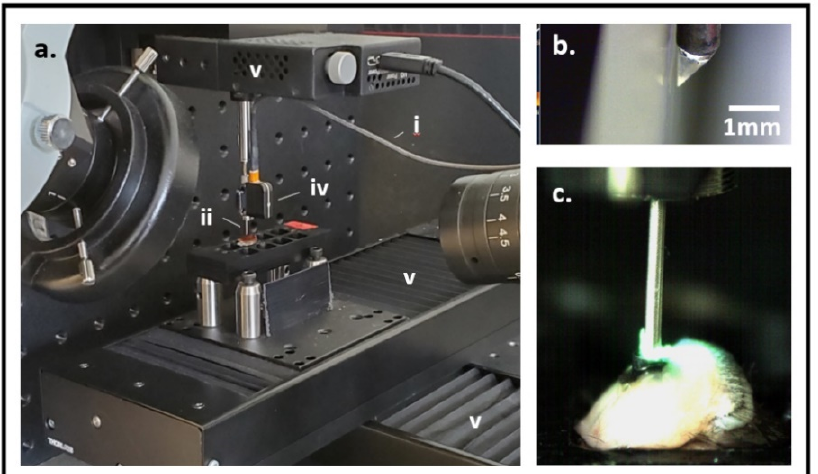
Figure 2. ( a ) Experimental set-up for live tissue fluorescence imaging. An optical fiber (i) delivers light excitation through a gradient index (GRIN) lens imaging probe (ii) into a tissue sample (not shown). The resultant fluorescent signal is captured by an external charge-coupled device (CCD) optical detector (iv) for 2-color fluorescence imaging. 4-axis (x, y, z linear and rotational) stage system (v) allows precise positioning of the imaging probe within the tissue sample. ( b ) GRIN lens imaging probe tip with triangular prism for side-viewing. ( c ) Imaging probe is placed through the microdevice into live murine tumoral tissue to image fluorescent drug and assay signal.